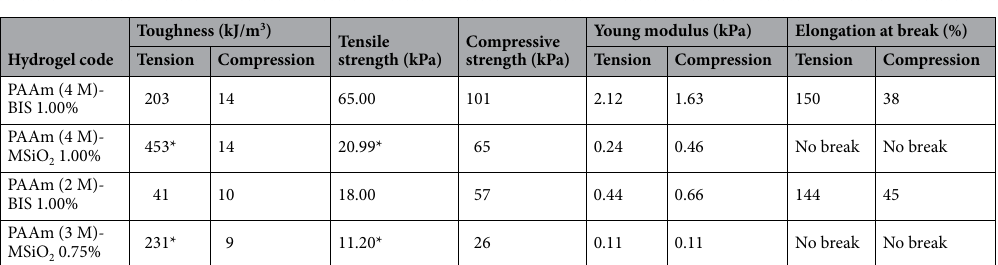
Table 2. Comparison of tensile and compressive properties of PAAm-BIS and PAAm-MSiO 2 hydrogels prepared by changing the concentration of AAm, BIS, and MSiO 2 . *Due to the maximum limit of the instruments, the parameter has to be calculated after 24 times of elongation without a break in samples.